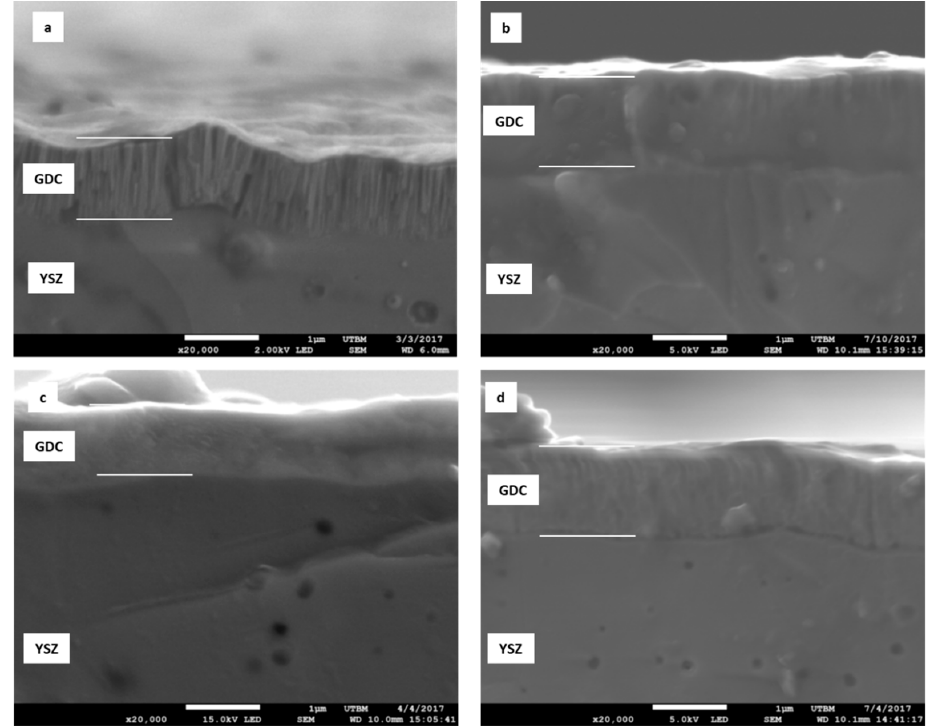
Figure 2. SEM micrographs of GDC coating as function of the total pressure ( a , c ) 0.5 Pa and ( b , d ) 0.1 Pa. ( a , b —as deposited; c , d —after annealing treatment under static air for two hours at 1000 °C).